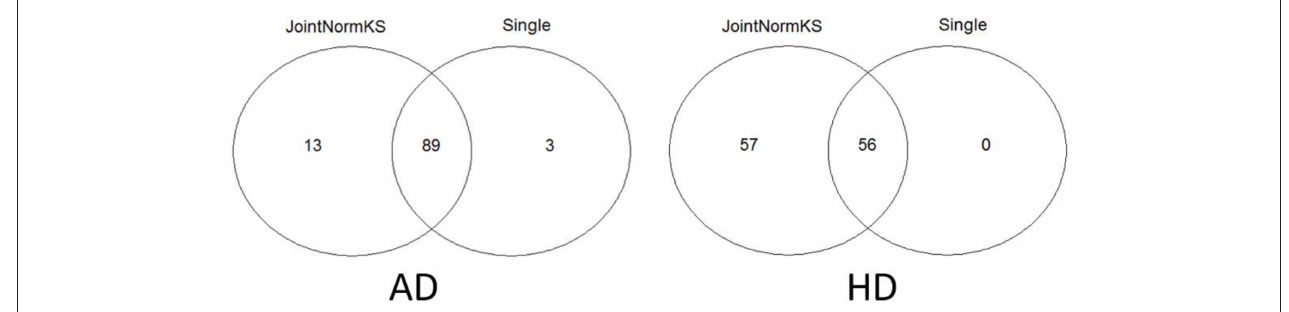
FIGURE 4 | Venn diagram of identified enriched pathways by JointNormKS and single data set analysis in AD and HD data sets. FDR cutoff is set to 0.1.